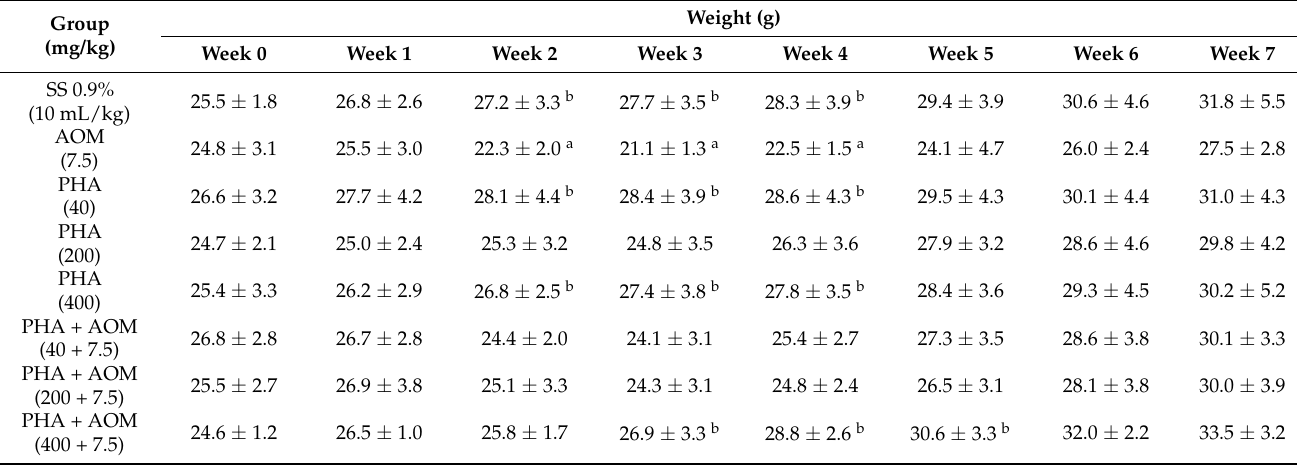
Table 1. Body weight determined in the experimental mice throughout the